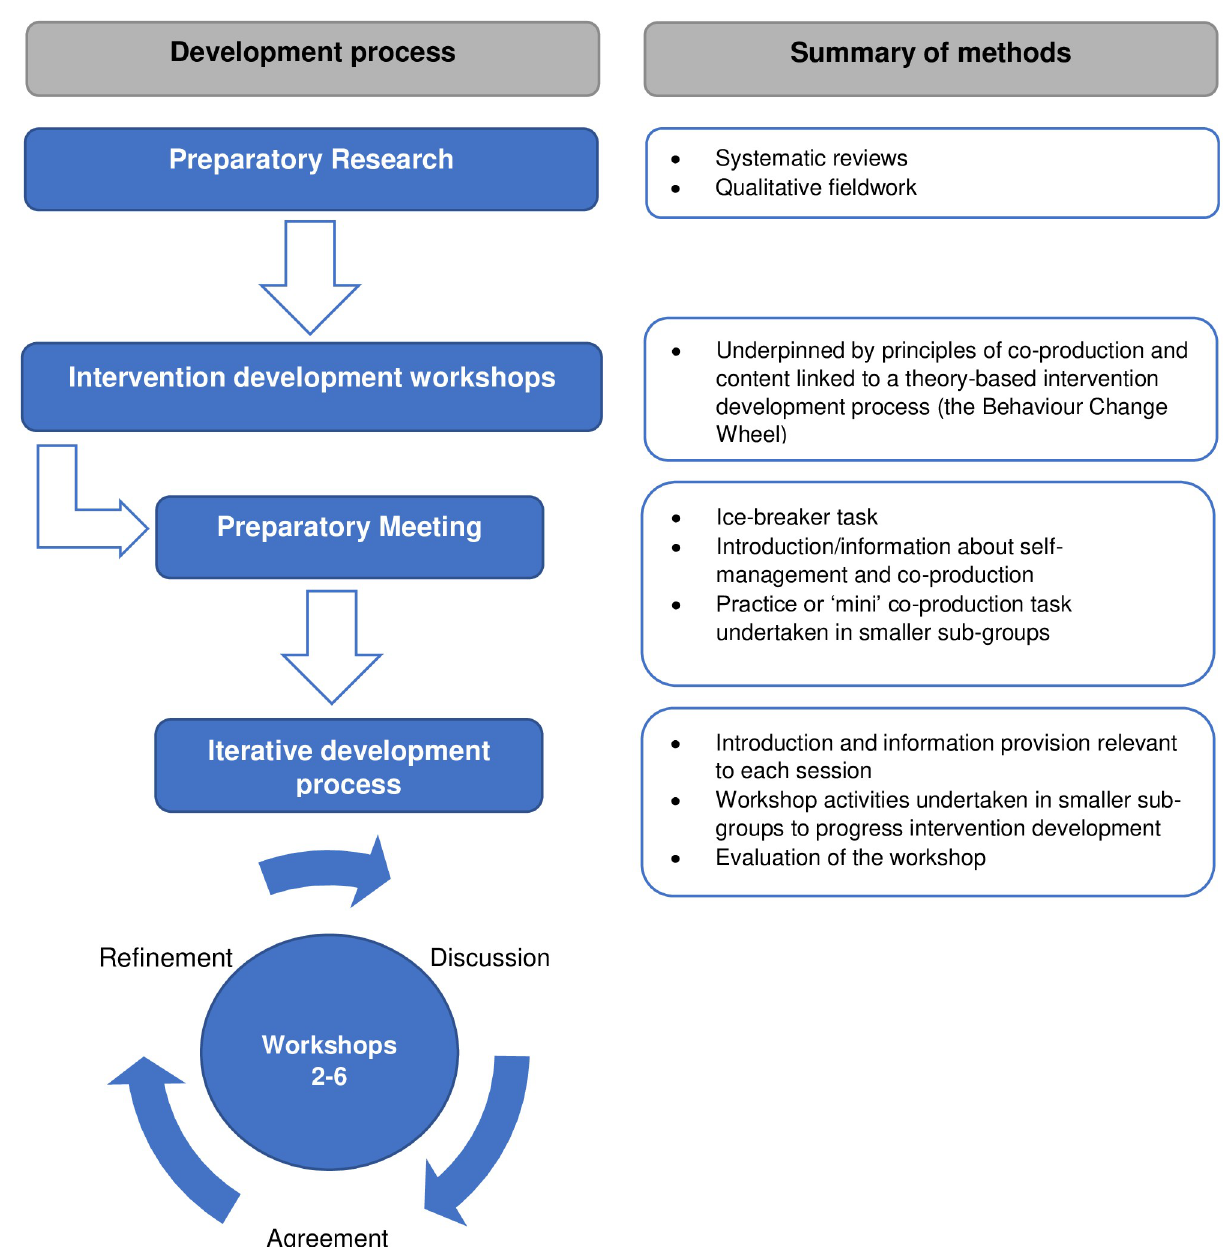
Fig 1. Summary of intervention development